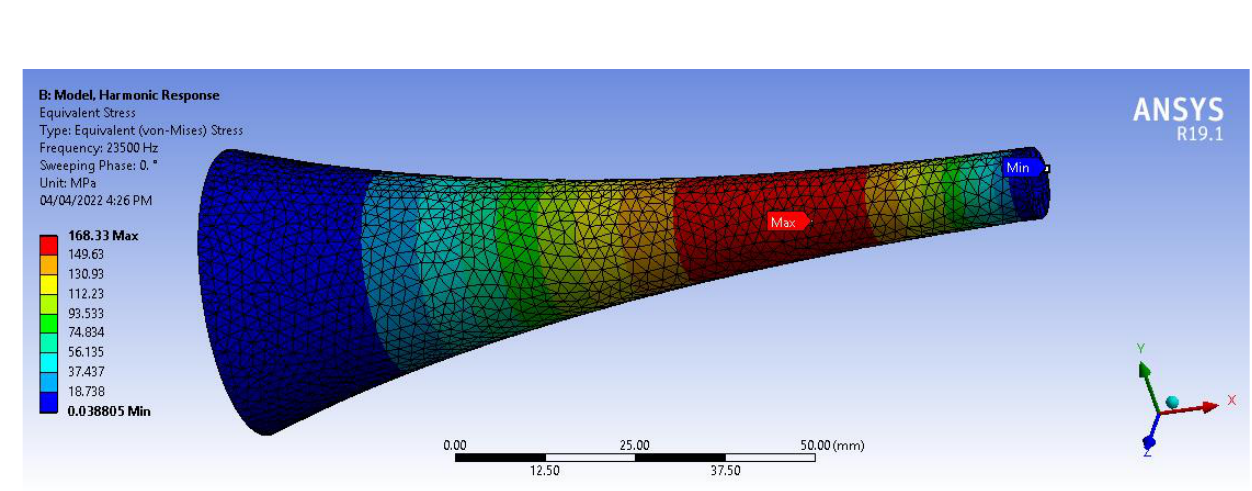
Figure 8. Variation of equivalent stress along the axial length of titanium catenoid horn